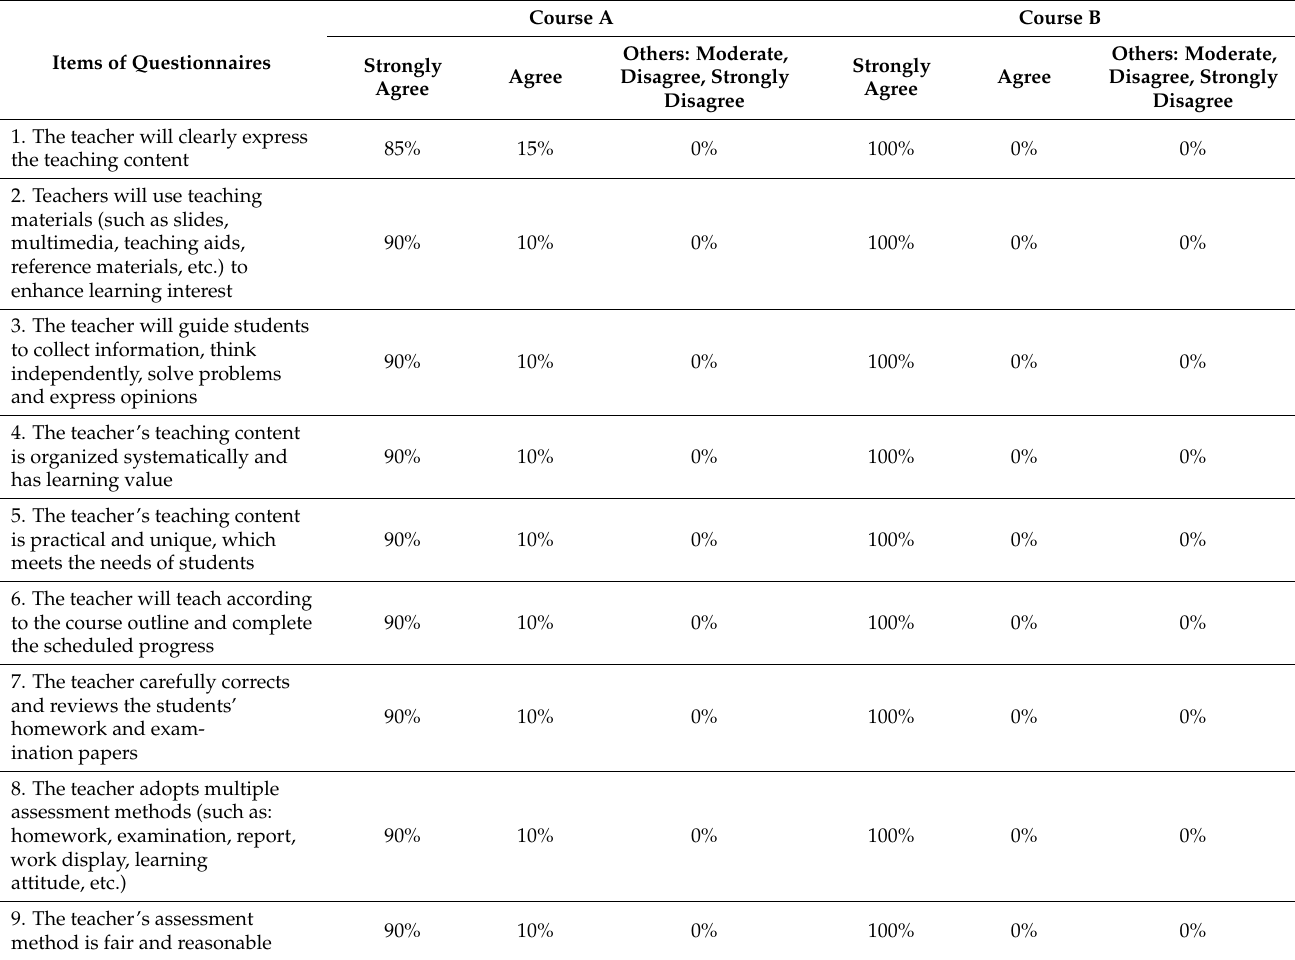
Table 7. Student’s learning satisfaction scores from